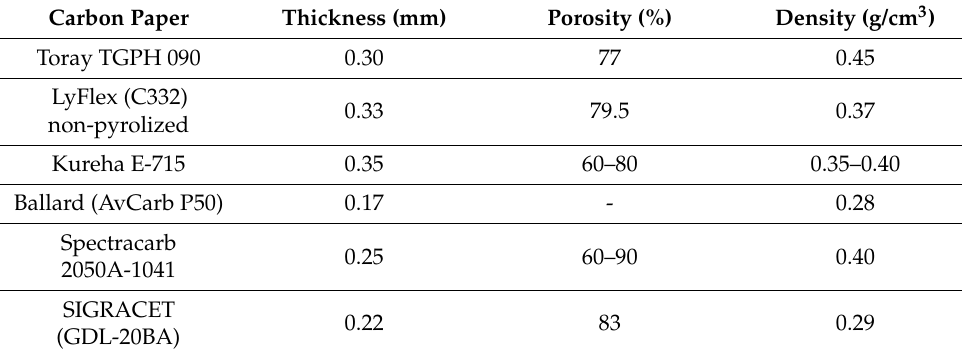
Table 1. Commercially Available Carbon Papers.